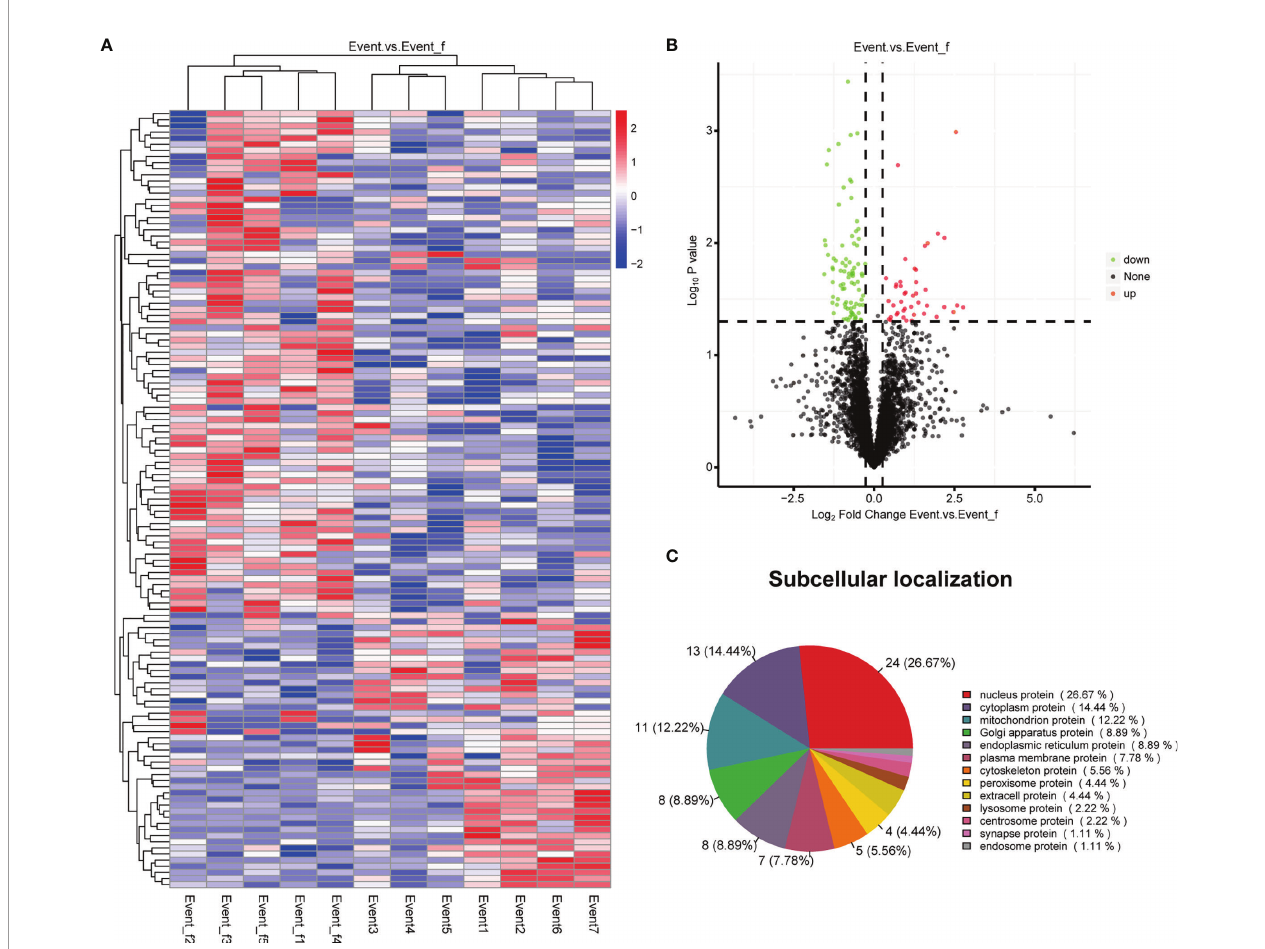
FIGURE 4 | Heatmap, volcano plot and subcellular localization pie chart of the differentially expressed proteins (DEPs). (A) Heatmap of the DEPs. (B) Volcano plot of the DEPs. (C) Subcellular localization pie chart of the